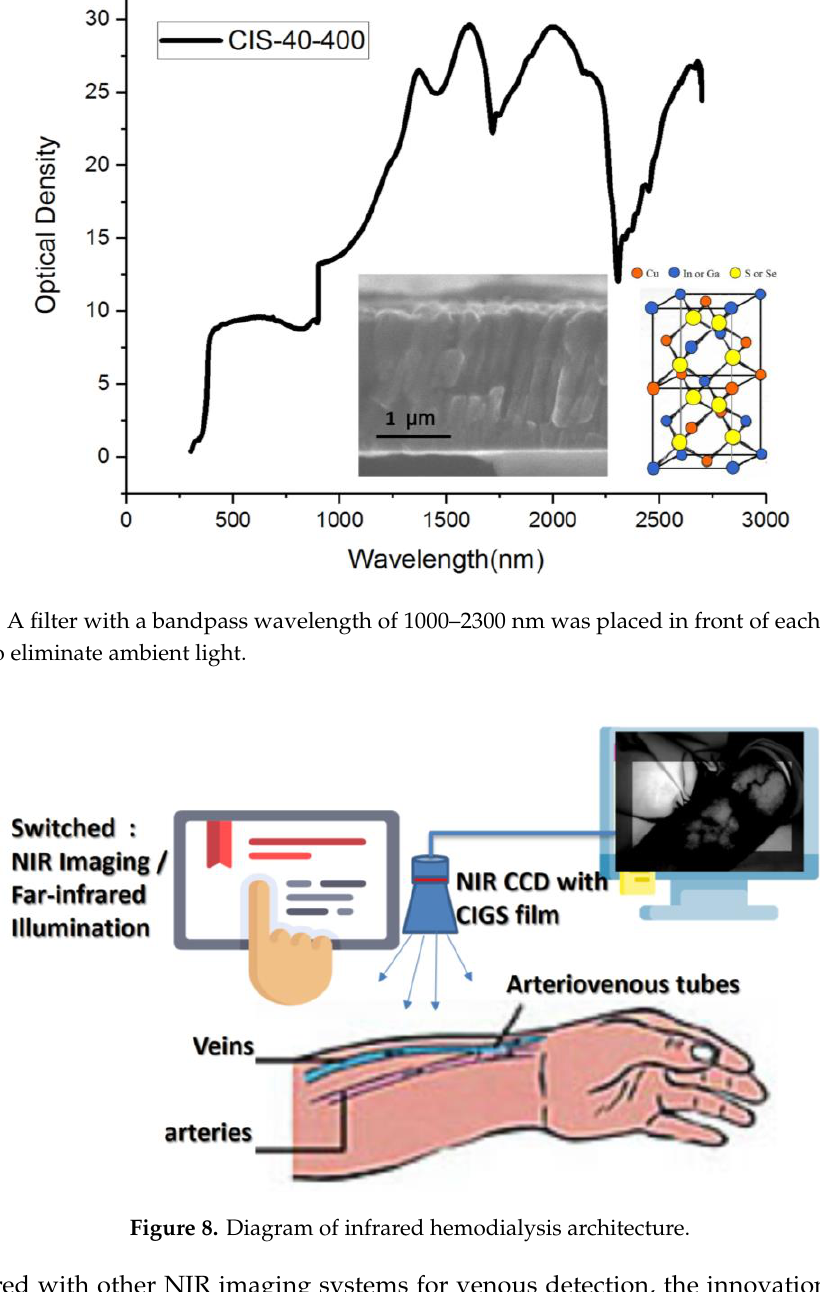
Figure 8. Diagram of infrared hemodialysis architecture.